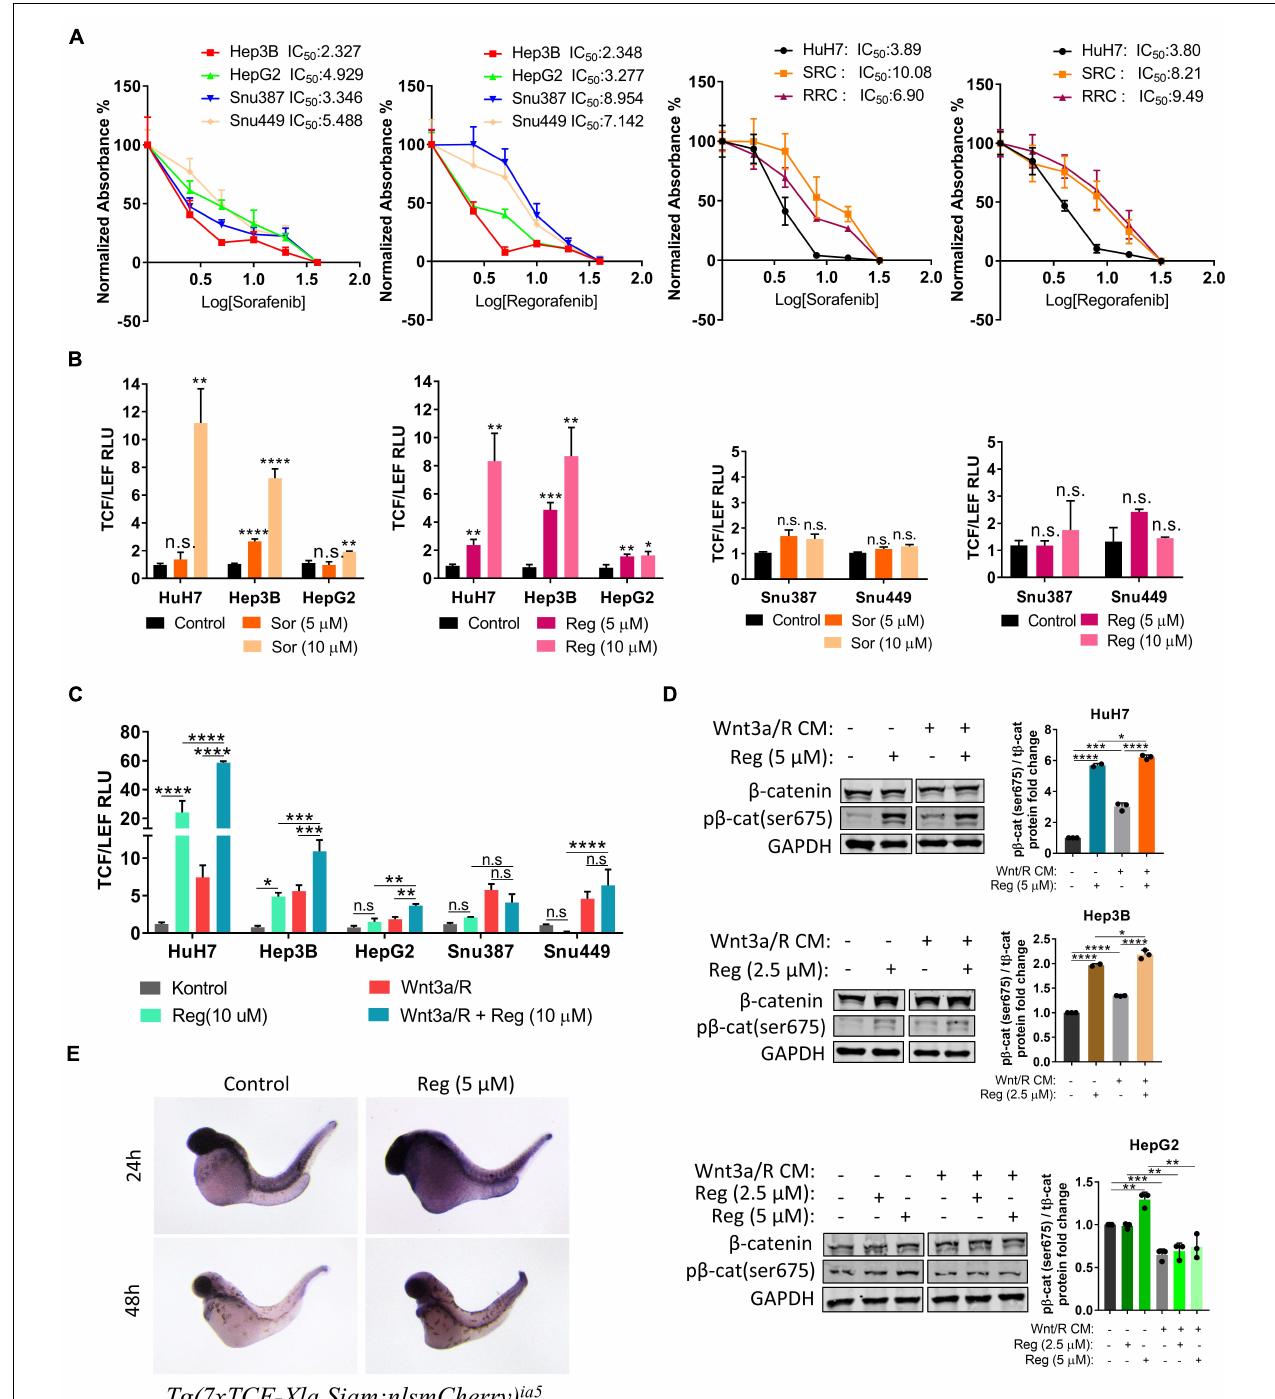
FIGURE 1 | Regorafenib increases TCF/LEF reporter activity both in vitro and in vivo . (A) MTT analysis demonstrates IC50 values for various HCC cell lines. RRC: Regorafenib resistant clone SRC: Sorafenib resistant clone (B) TCF/LEF reporter assay shows that sorafenib and regorafenib significantly increase the β -catenin transcriptional activity in hepatoblast-like HCC cell lines but not in mesenchymal-like HCC cell lines. (C) Regorafenib enhances Wnt3a/R-Spo1 induced TCF/LEF reporter transcriptional activity in hepatoblast-like HCC cell lines . (D) Regorafenib treatment increases phospho- β -catenin in hepatoblast-like HCC cells. (E) Whole-mount in situ hybridizations using mCherry probe on untreated and regorafenib treated Tg(7xTCF-Xla.Siam) Wnt/ β -catenin reporter fishes demonstrate that regorafenib treatment increases the TCF/LEF activity in vivo . Data represent the average of at least three independent experiments. p > 0.05 (n.s.), p ≤ 0.05 (*), p ≤ 0.01 (**), p ≤ 0.001 (***), p ≤ 0.0001 (****). Error bars indicate standard deviation (SD).